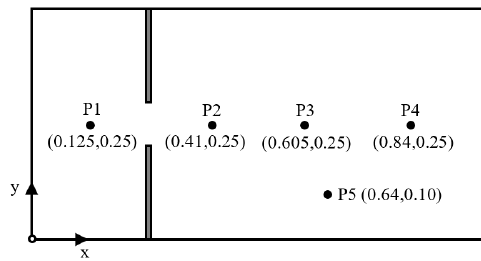
Figure 2. Measurement